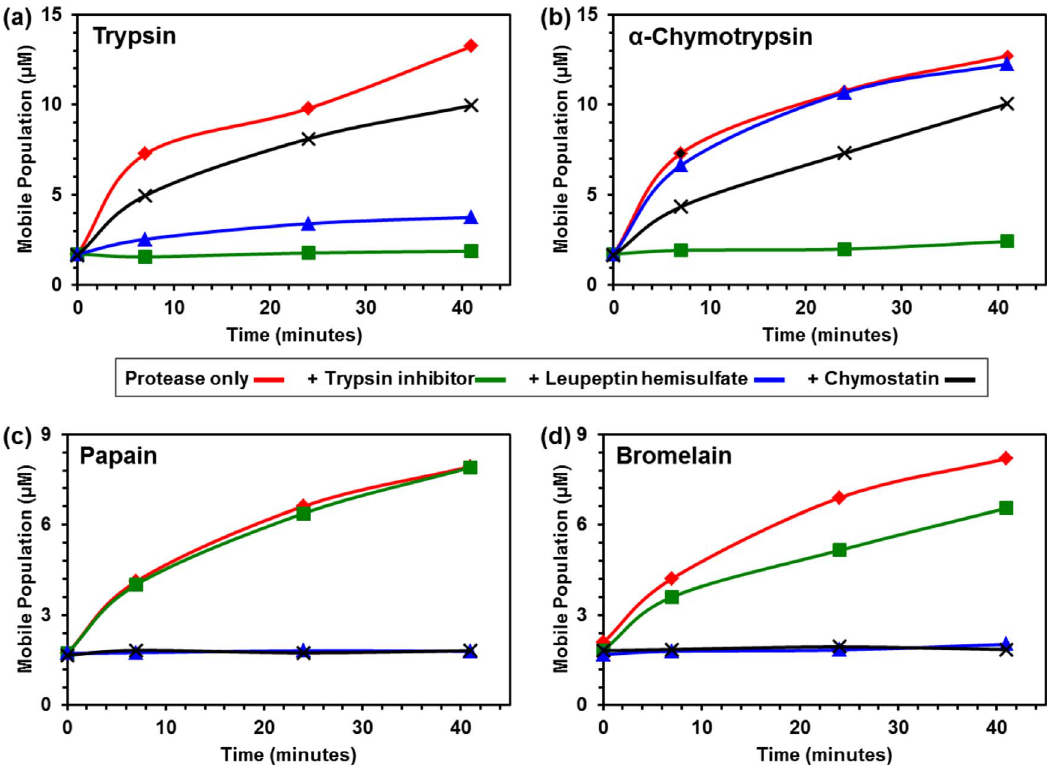
Figure 4. Increase in mobile population over a 41-minute time course for digestion of BSA by four proteases: Trypsin, a - chymotrypsin, papain, and bromelain. Each protease acted alone or in the presence of three known protease inhibitors. Error bars are too small to be seen at this